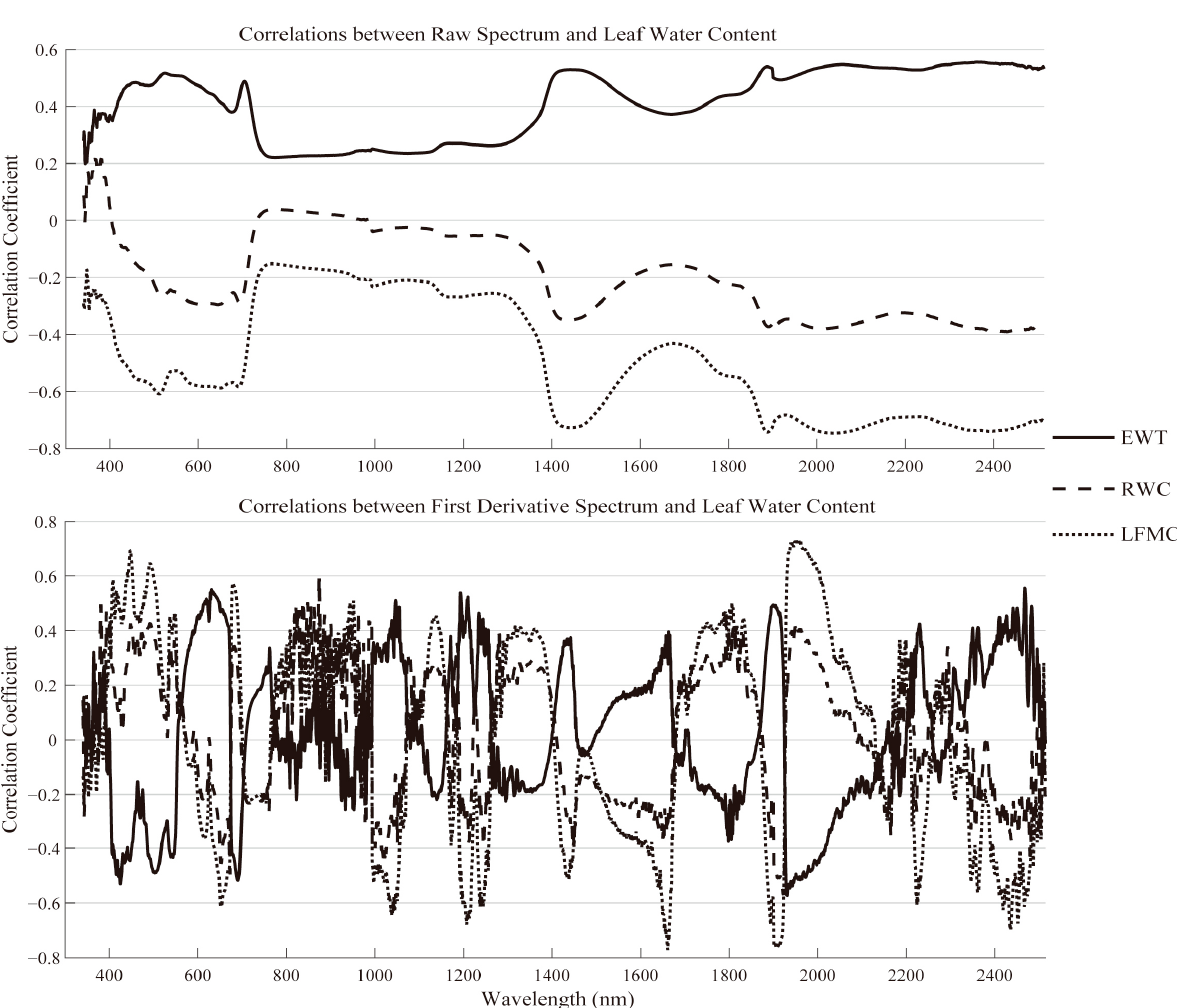
Figure 5. Coefficients of correlation between EWT, RWC, LFMC, and the raw leaf and first-derivative spectral data.